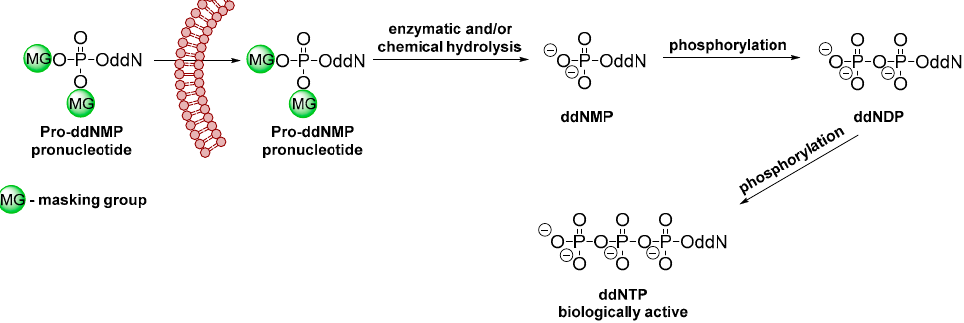
Scheme 1. A general principle of the monophosphate pronucleotides mode of action.